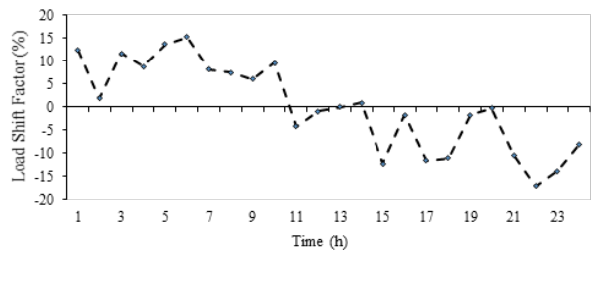
Fig. 4. Load shift factor (  ) in 24